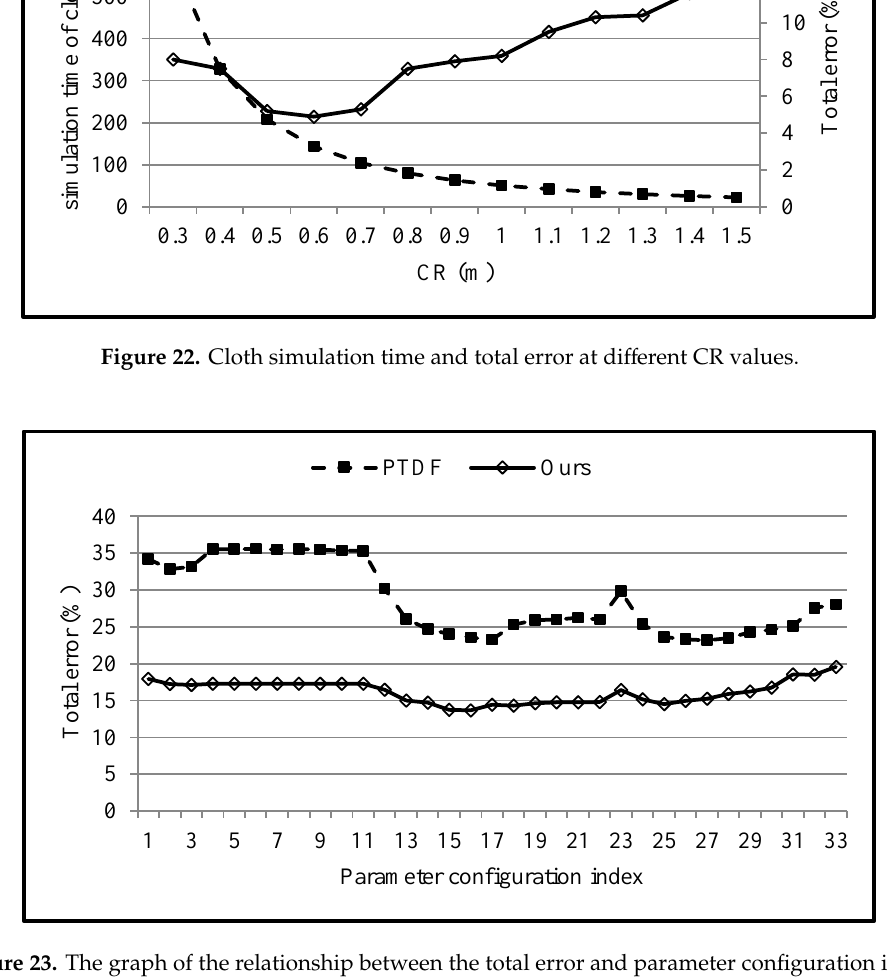
Figure 23. The graph of the relationship between the total error and parameter configuration index.